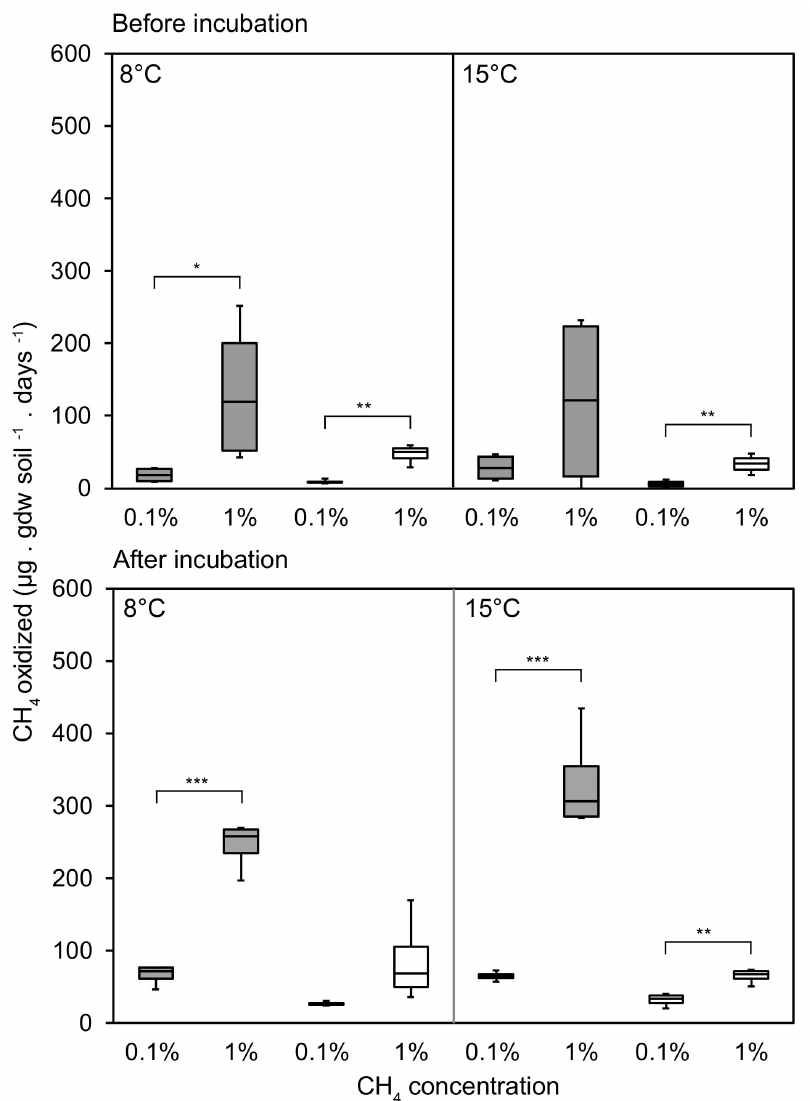
Figure 1. CH 4 oxidation rates from Exp I, emphasizing the comparison between 0.1% and 1% headspace CH 4 concentrations. Results are shown for measurements collected before (top) and after (bottom) the three-week incubation period, and at 8 (left) and 15 ◦ C (right). Grazed microcosms are shown in gray; exclosed microcosms in white. Comparison using linear mixed models with peat blocks as random variables shows significant differences in the CH 4 oxidation rates between CH 4 concentrations (* p < 0.05; ** p < 0.01; *** p <